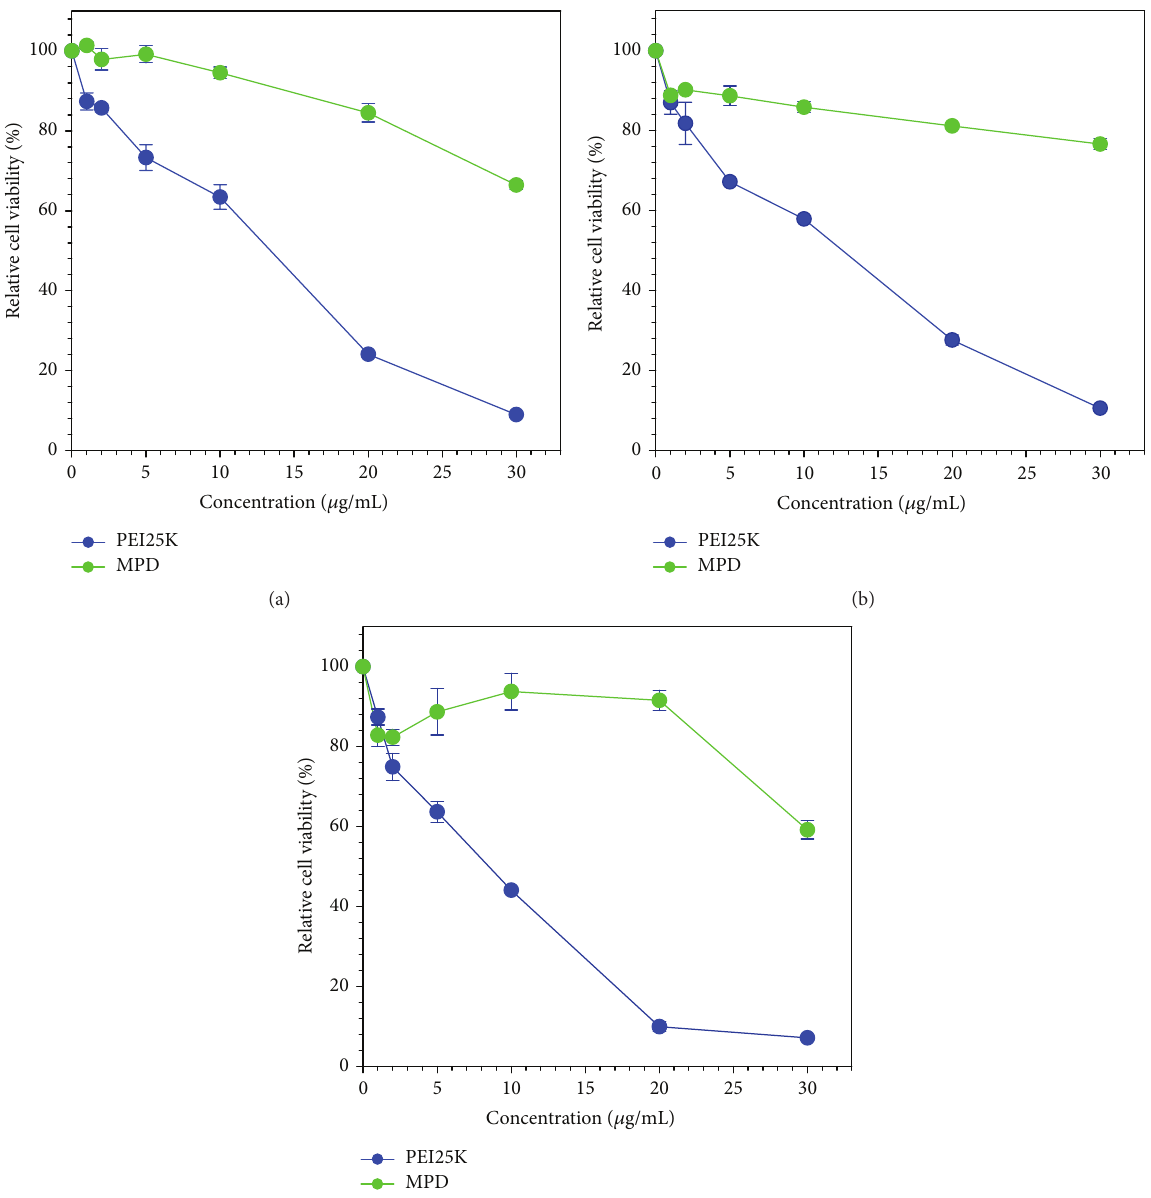
Figure 5: MTT assay results of MPD in A549 (a), C2C12 (b), and HEK293 (c)